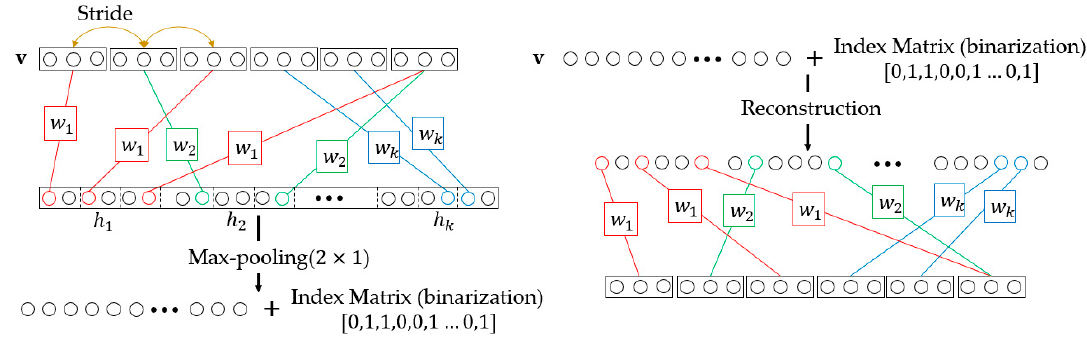
Figure 2. Downsampling-Convolutional RBM.